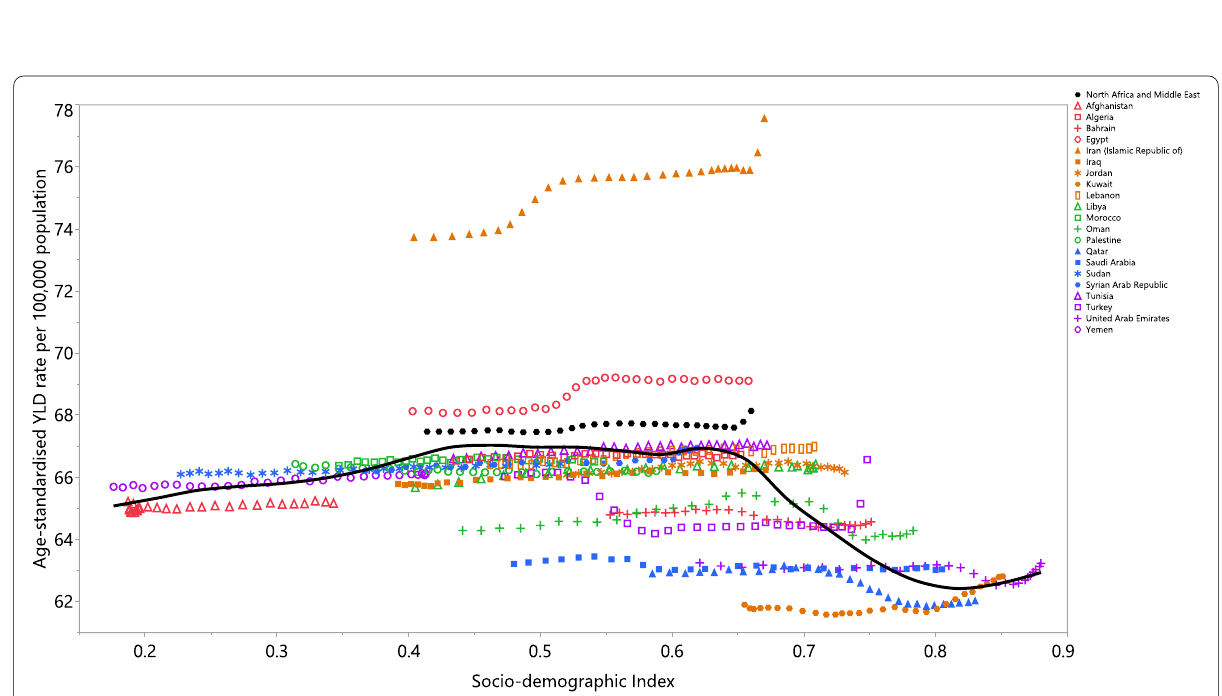
Fig. 4 Age‑standardised YLD rates of tension‑type headache for 21 countries and territories, by SDI in 2019; Expected values based on the Socio‑demographic Index and disease rates in all locations are shown as the black line. Each point shows the observed age‑standardised YLD rate for each country in 2019. YLD years lived with disability. SDI Socio‑demographic Index (Generated from data available from http:// ghdx. healt = = hdata. org/ gbd‑ resul ts‑